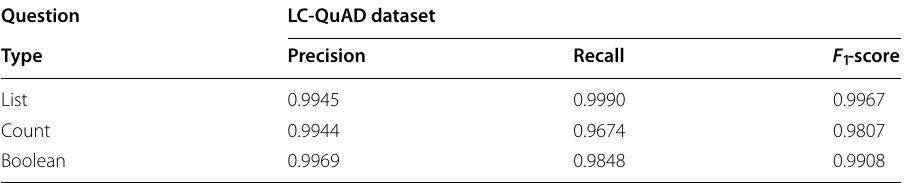
Table 3 Question type classification performance on LC-QuAD